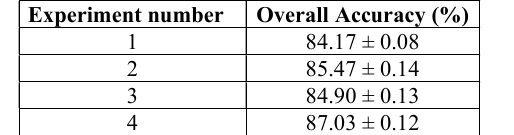
Table 5: Average overall accuracy obtained for the four experiments.